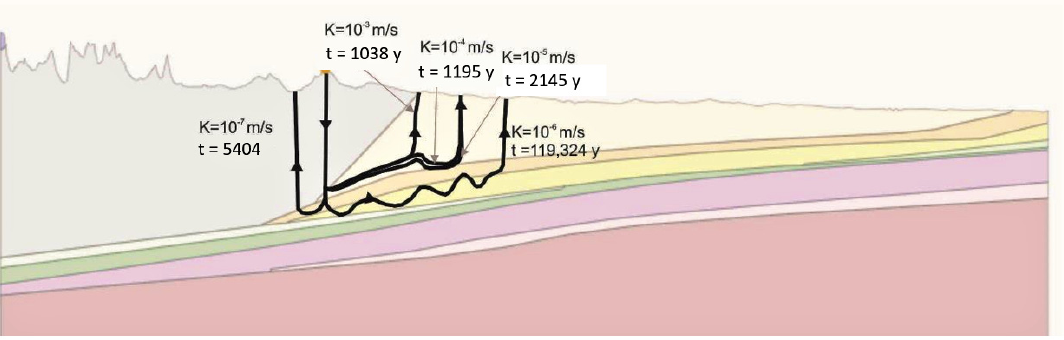
Figure 14. Sensitivity analysis for the Paskapoo formation.